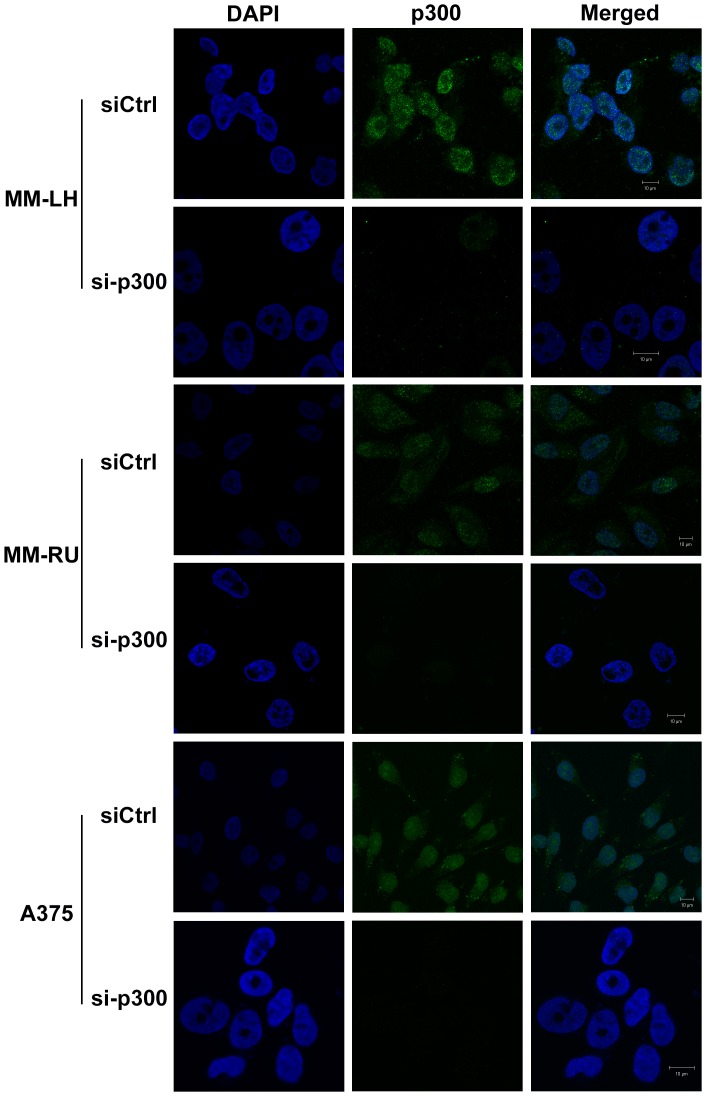
p300 is expressed in both nucleus and cytoplasm Silencing of p300 leads to abrogation of p300 expression in both nucleus and cytoplasm.Cells were grown on cover slips and transfected either with control siRNA (siCtrl) or p300 siRNA (si-p300) and after 48 hrs fixed as described in the methods section. Immunofluorescent staining was performed on the cells grown on cover slips using anti-p300 antibody (green). Nucleus was stained with DAPI (blue).